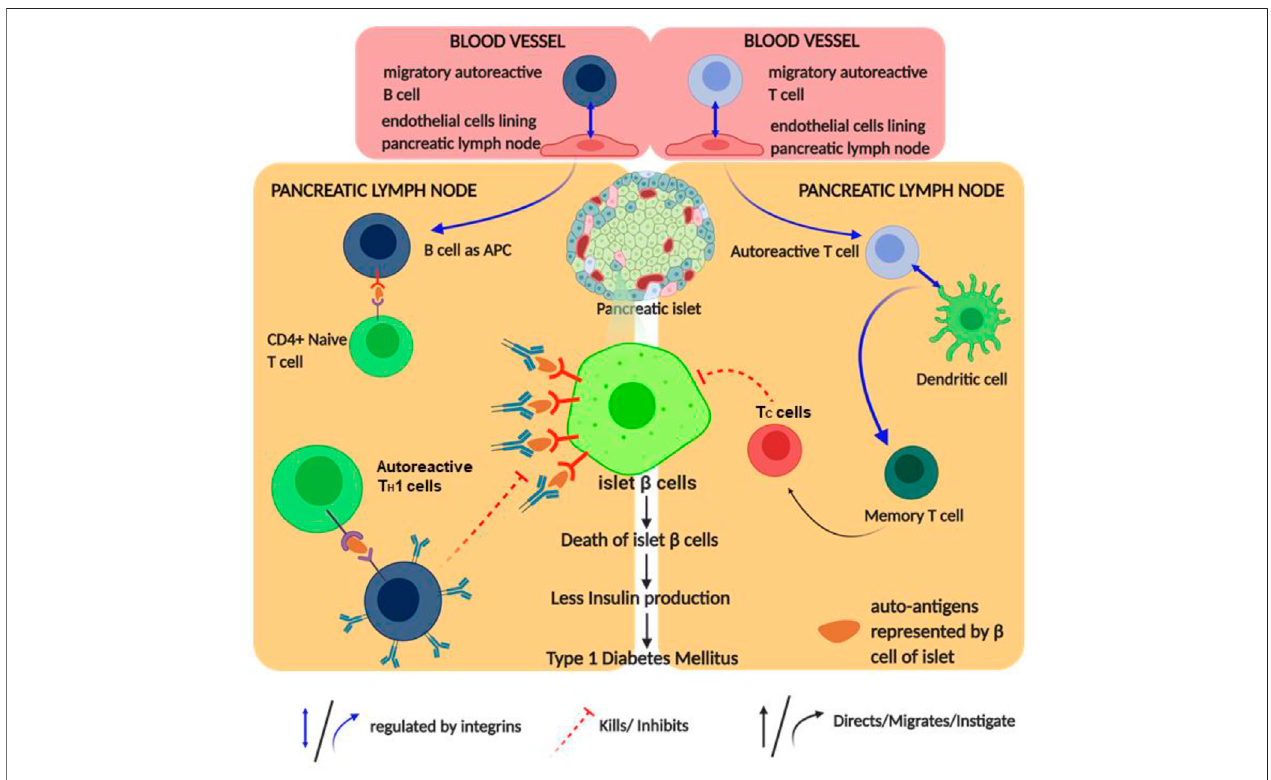
FIGURE 4 | Schematic diagram of type 1 diabetes mellitus (T1DM) pathophysiology and its regulation by integrin: the fi gure provides a schematic diagram of how autoimmune diabetes mellitus causes and integrin regulates this disease. Blue arrows denote signaling/mechanism being regulated by integrin.